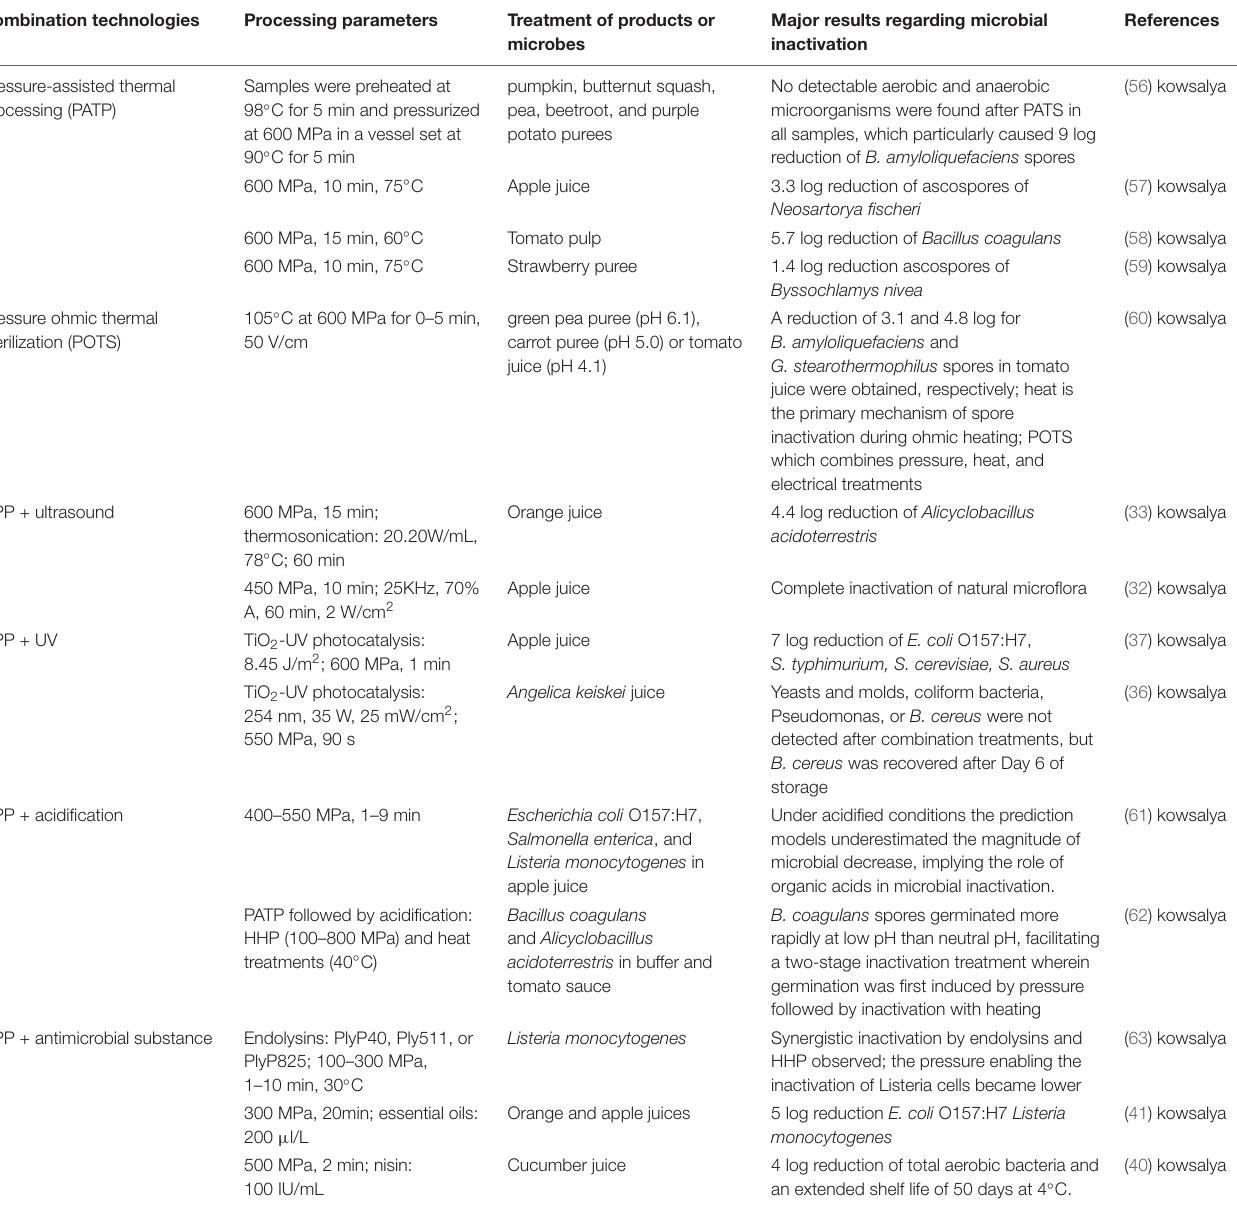
TABLE 1 | The effect of high pressure processing (HPP) in combination with other hurdle technologies on the microbiology of different fruit and vegetable